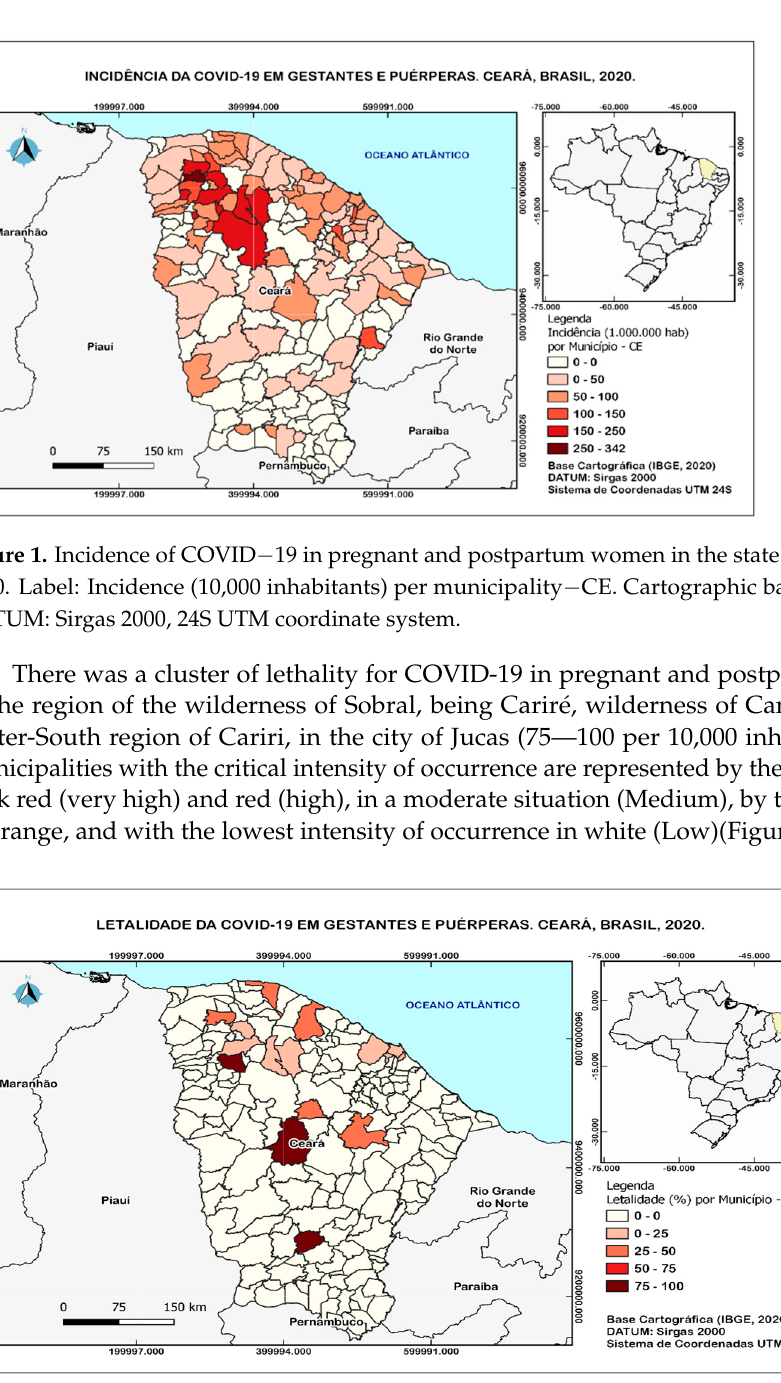
Figure 2. Lethality of COVID − 19 in pregnant and postpartum women in the state of Ceará, Brazil, 2020. Label: Lethality (%) per municipality − CE. Cartographic base (IBGE, 2020). DATUM: Sirgas 2000, 24S UTM coordinate system.